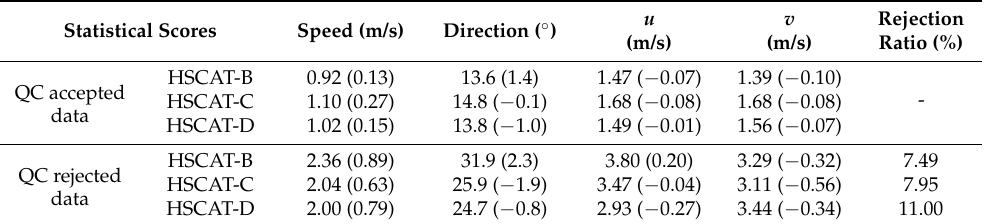
Table 3. The same as Table 2, but using the mean wind vectors of the collocated buoy data as the